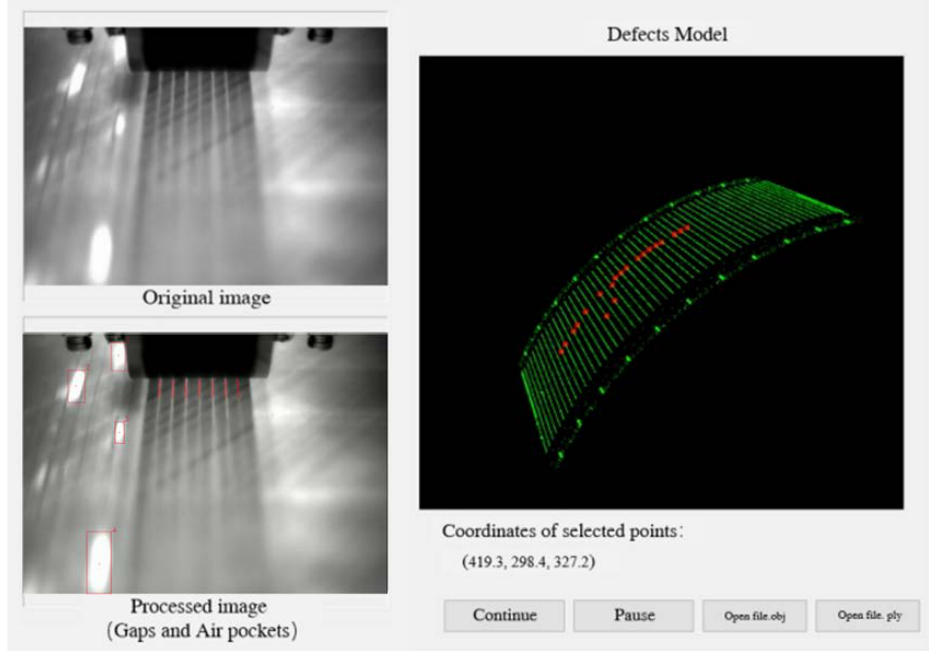
Figure 10. Human-computer interaction interface of defect inspection based on the proposed sys-